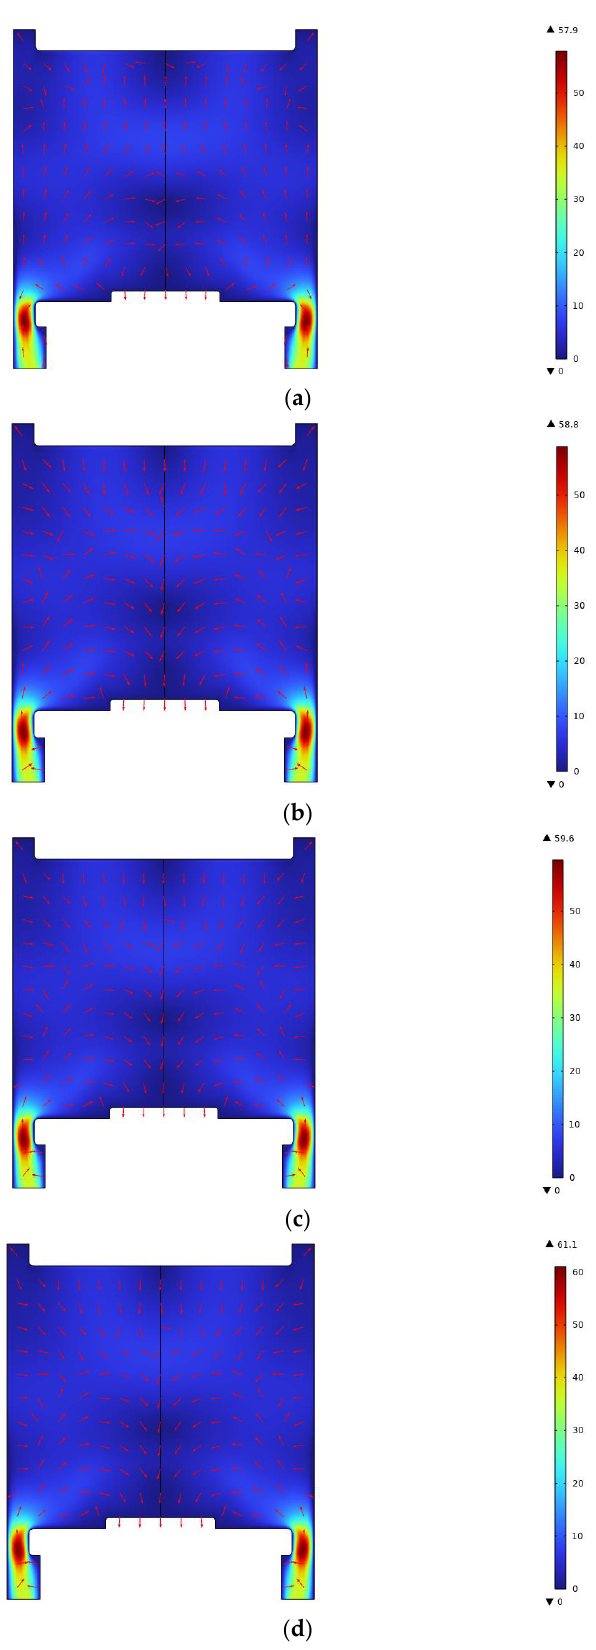
Figure 4. Contours of velocity distribution in the deposition chamber (m/s). ( a ) 0 V; ( b ) +100 V; ( c ) +200 V; and ( d ) +300